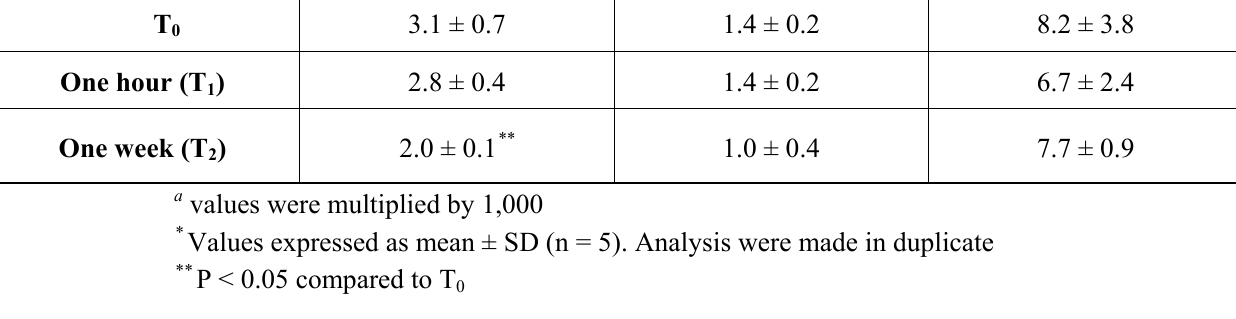
) and prolonged (one 1